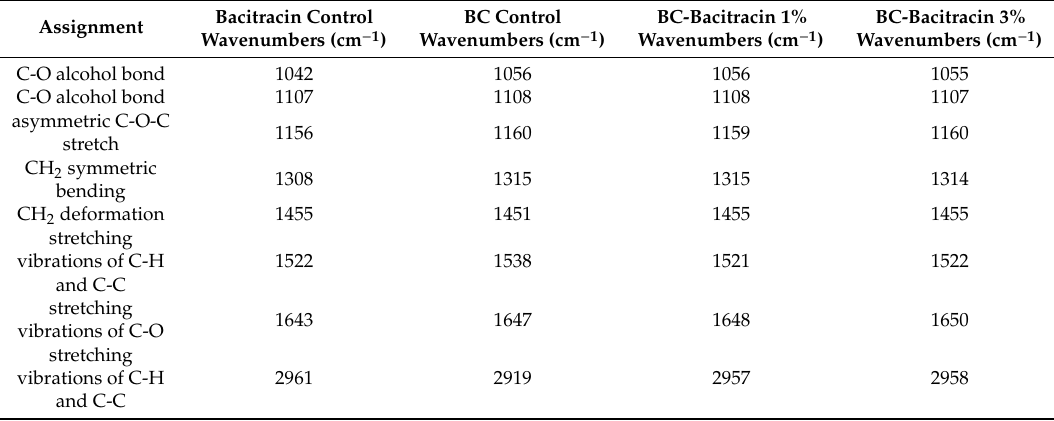
Figure 2. FTIR spectra of bacitracin control, BC-bacitracin 1%, BC-bacitracin 3%, and BC control. Table 1. Assignment of relevant IR absorption bands of bacitracin, BC control, BC-bacitracin 1%, and BC-bacitracin 3%.